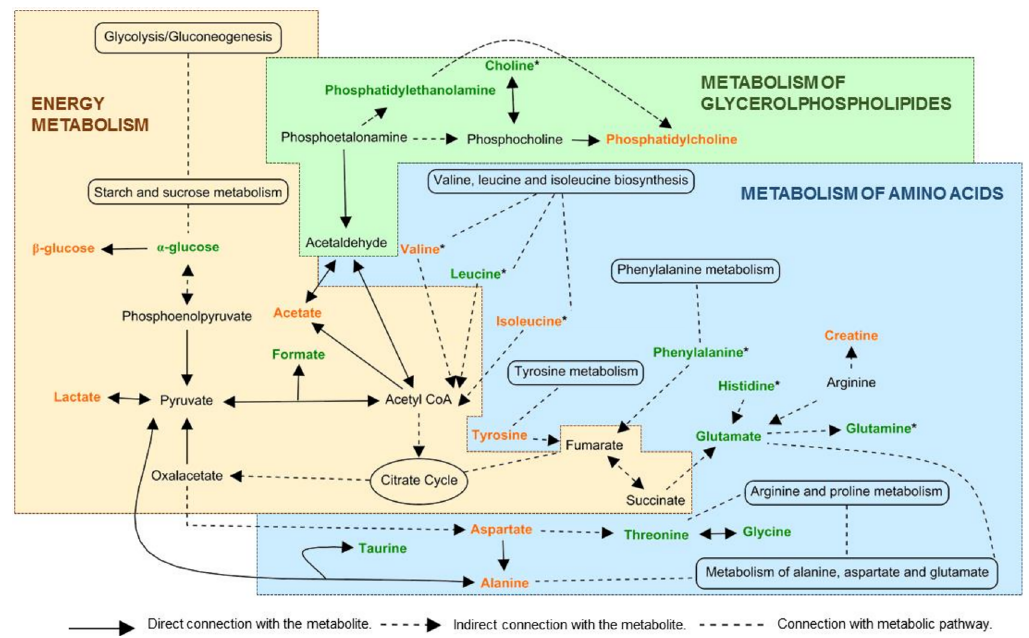
Figure 1 – Connection between the metabolic pathways of the most cited compounds among the selected studies.